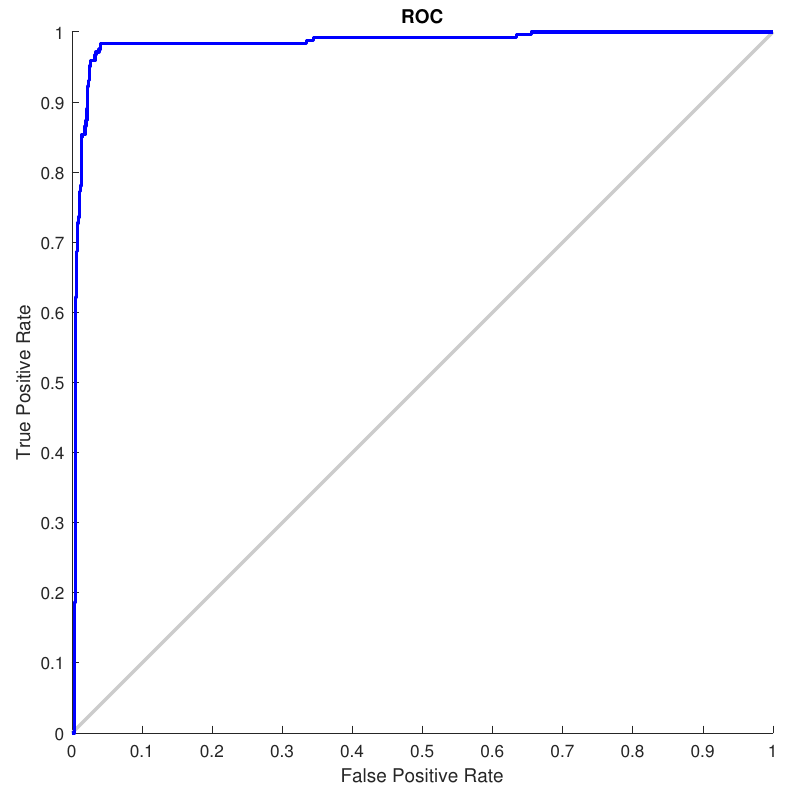
Figure 7. ROC curve plot based on the average TP and FP for all images in the database when the threshold was changed.